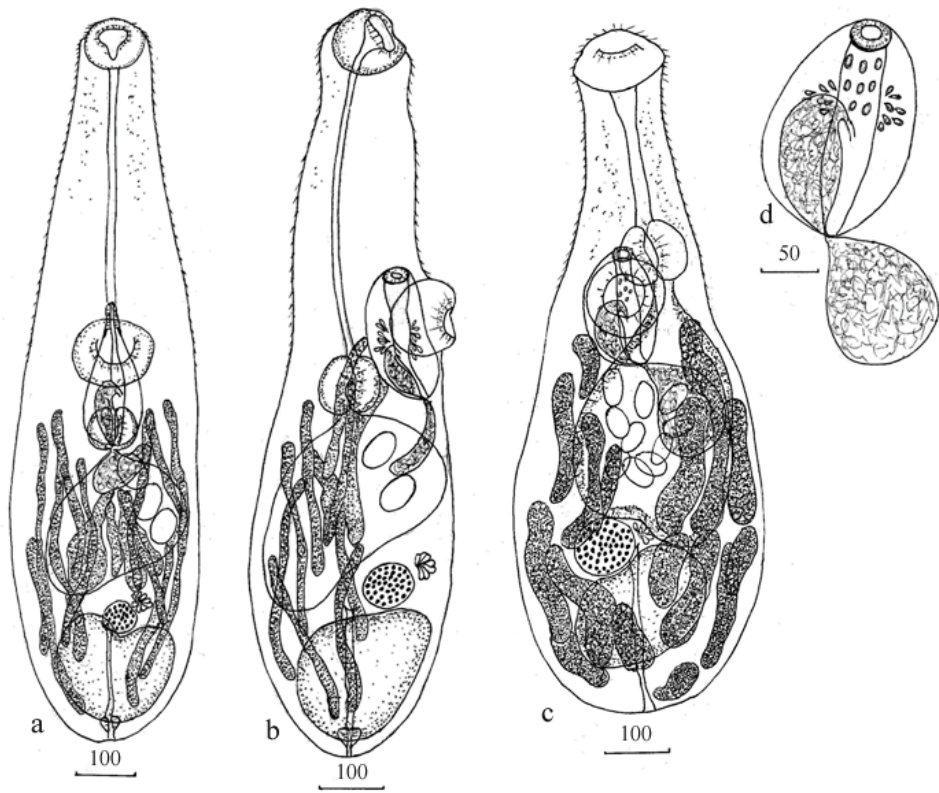
Figure 1. Paraunisaccoides elegans n. sp.: ( a ) adult worm ventral, ( b ) adult worm lateral; Unisaccus halongi n. sp.: ( c ) adult worms, ( d ) cirrus sac. Measurements are given in µm. Table 2. Measurements (µm) of adult worms of new species Paraunisaccus elegans n. sp. and Unisac- cus halongi n. sp. and known species Skrjabinolecithum lobolecithum and S. indicum.